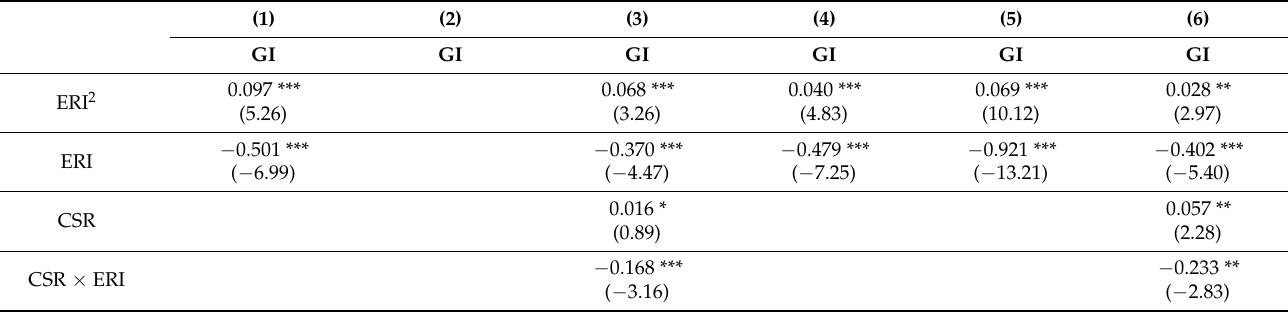
Figure 3. Regulatory Effect Diagram of Social Responsibility Information Disclosure. Table 4. Regression results of the main